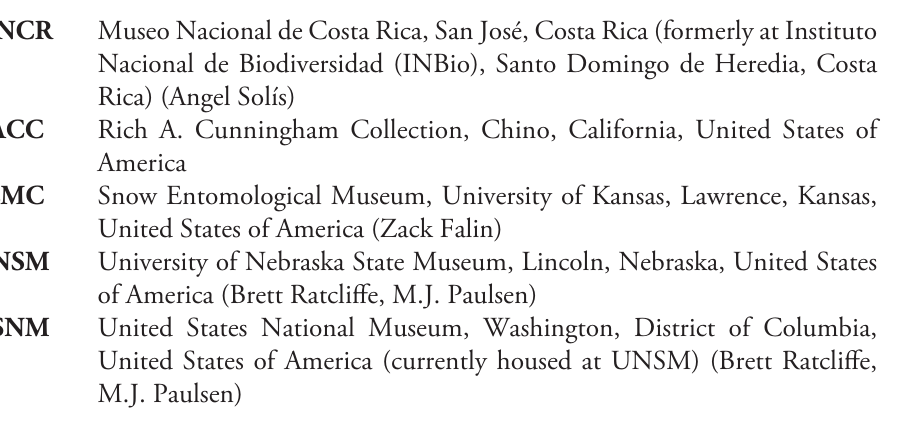
Label data, specimen images, and maps